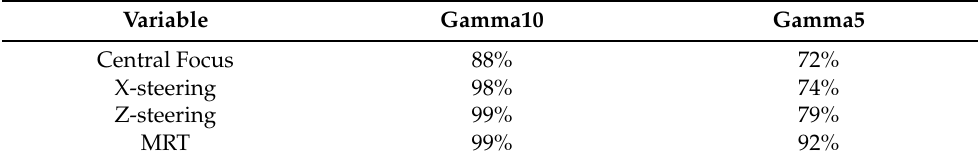
Table 2. Results of the gamma